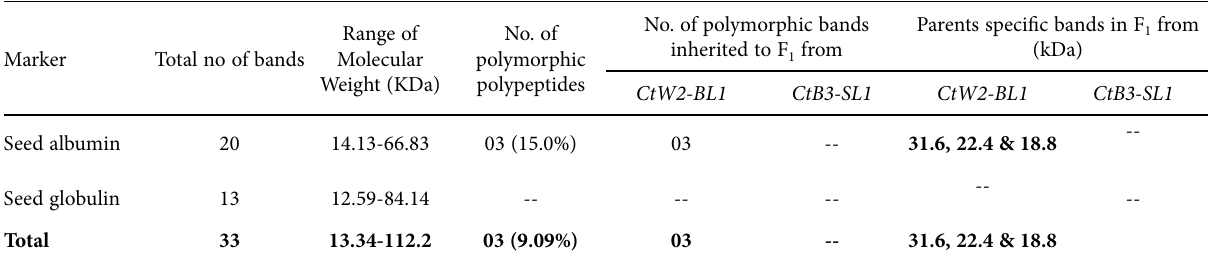
Table 3. Details of seed albumin and seed globulin markers inherited to the intraspecific F 1 hybrid.